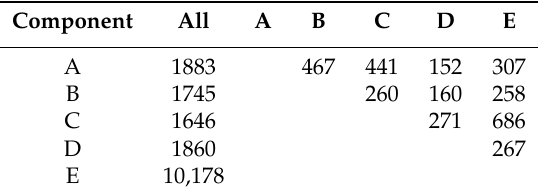
Table 1. Number of registered failures.